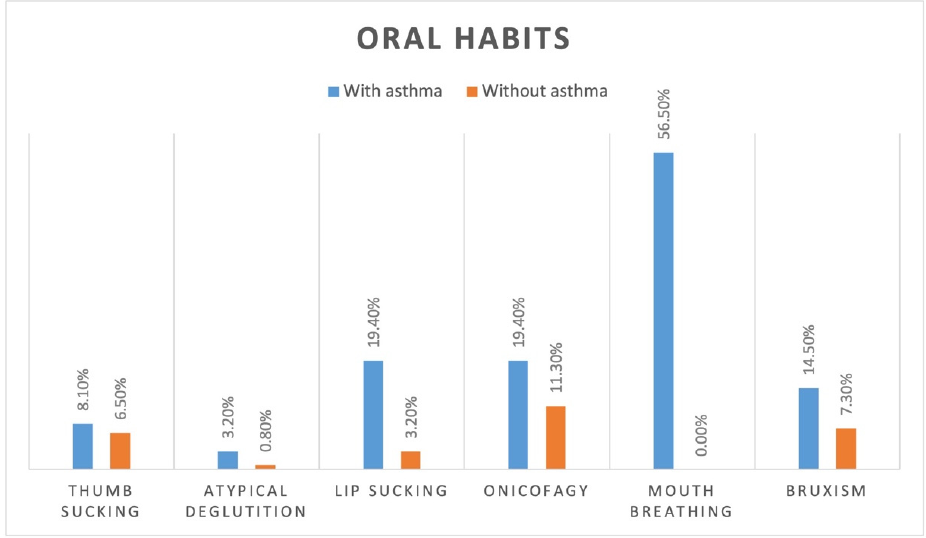
Figure 2. Frequency of oral habits by group.